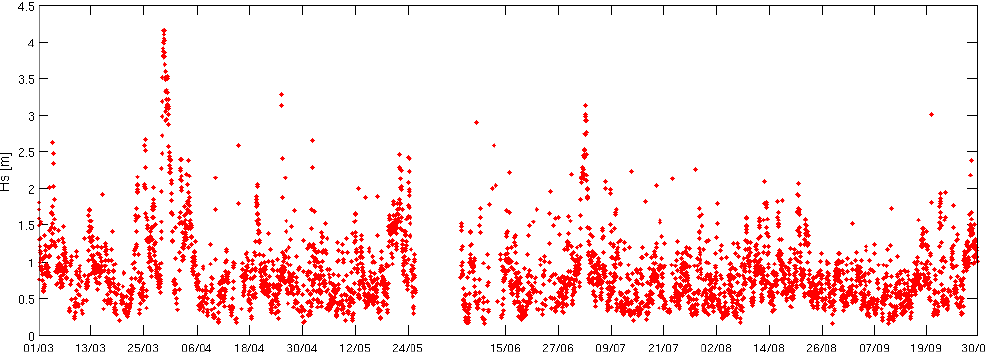
Figure 14. Treated HF radar data of the Alfacada antenna. Time series data are for dd/mm/2014.